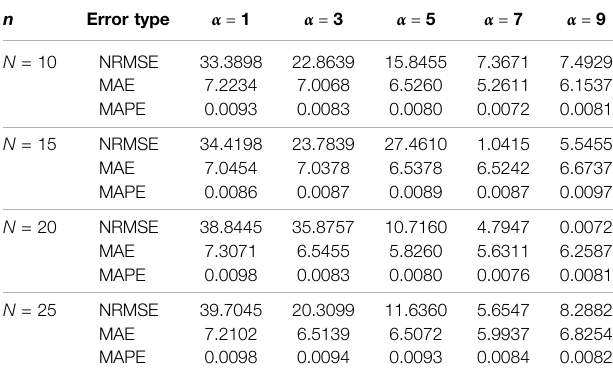
TABLE 3 | Errors of the test set for different α and N .